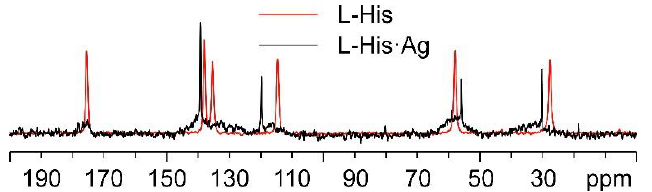
Figure 12. Overlay of the 13 C CPMAS spectra of L-His·Ag (in black) and pure L-His (in red).